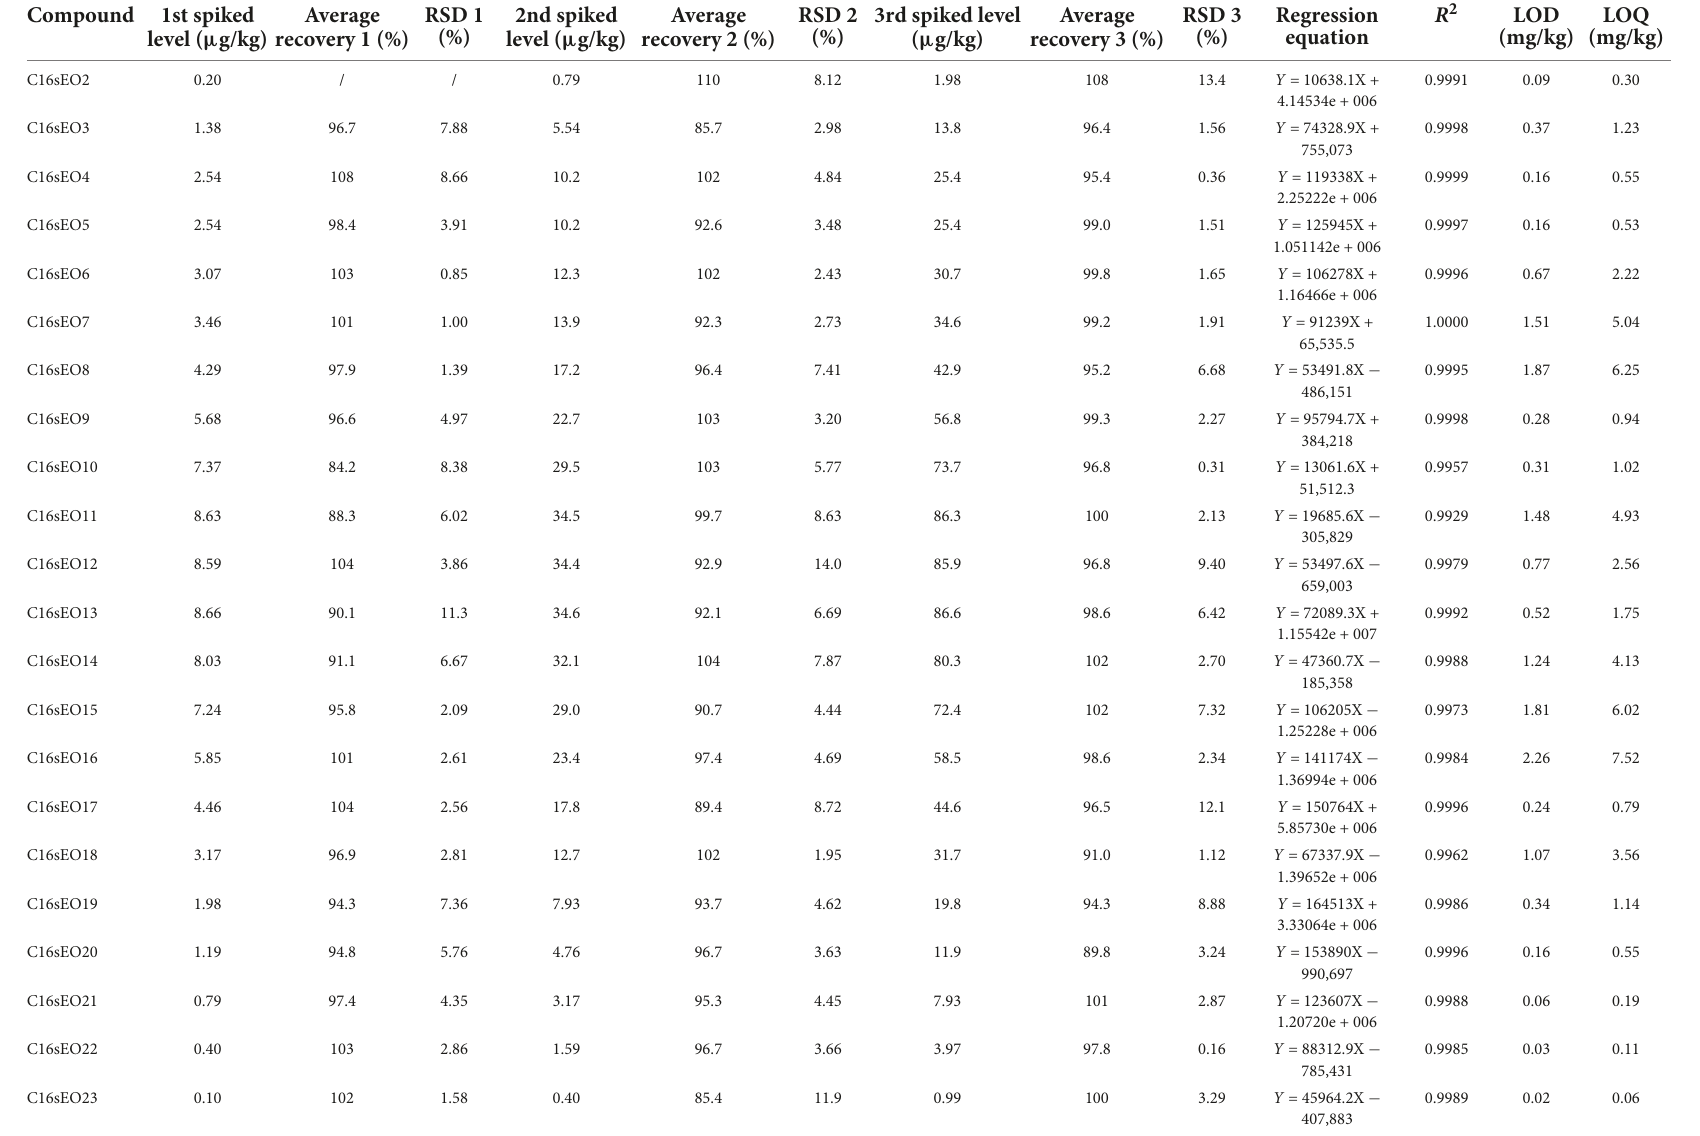
TABLE 1 Method validation of polyethoxylated tallow amine (POE-tallowamine) in citrus ( n = 3).